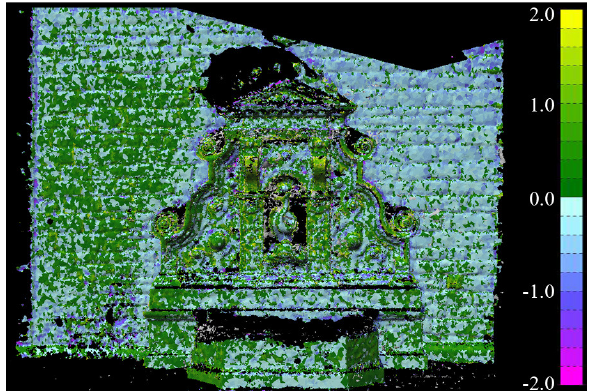
Figure 5. Orientation of Fountain sequence. Comparison between laser scanner and photogrammetric DSM (color bar in